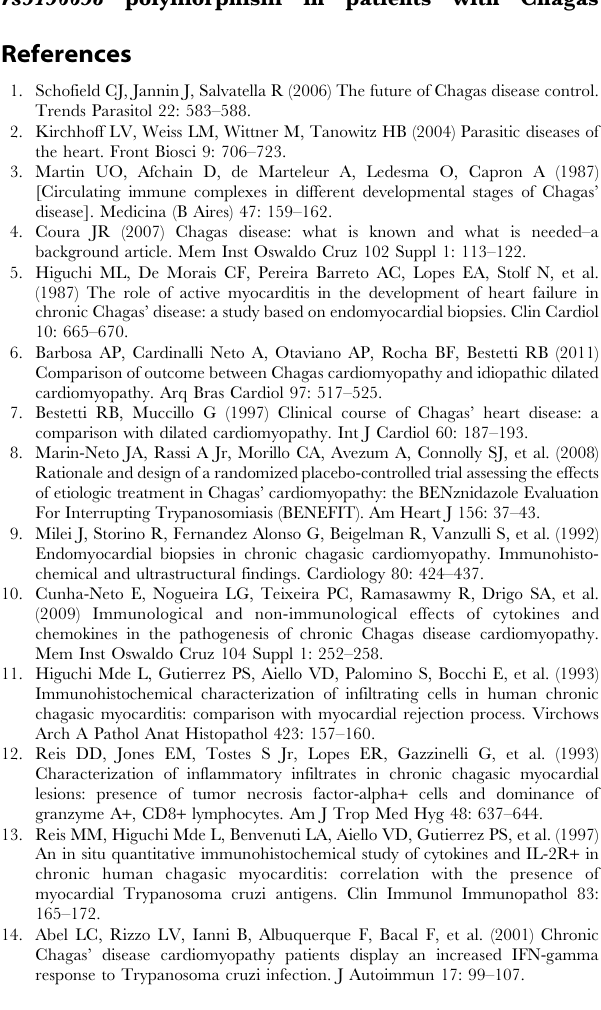
disease. CCC patients were further stratified by left ventricular ejection fraction values. Table S8 Genotype and allele frequencies for the CCL17 rs223827 polymorphism in patients with Chagas dis- ease. CCC patients were further stratified by left ventricular ejection fraction values. Table S9 SNPs in tight linkage disequilibrium with CXCL9 rs10336 and CXCL10